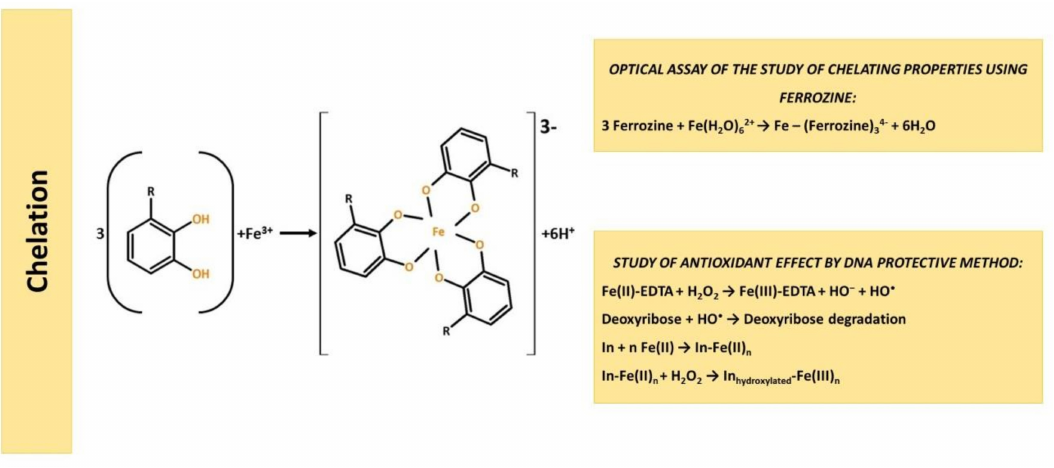
Figure 9. Chelating mechanism